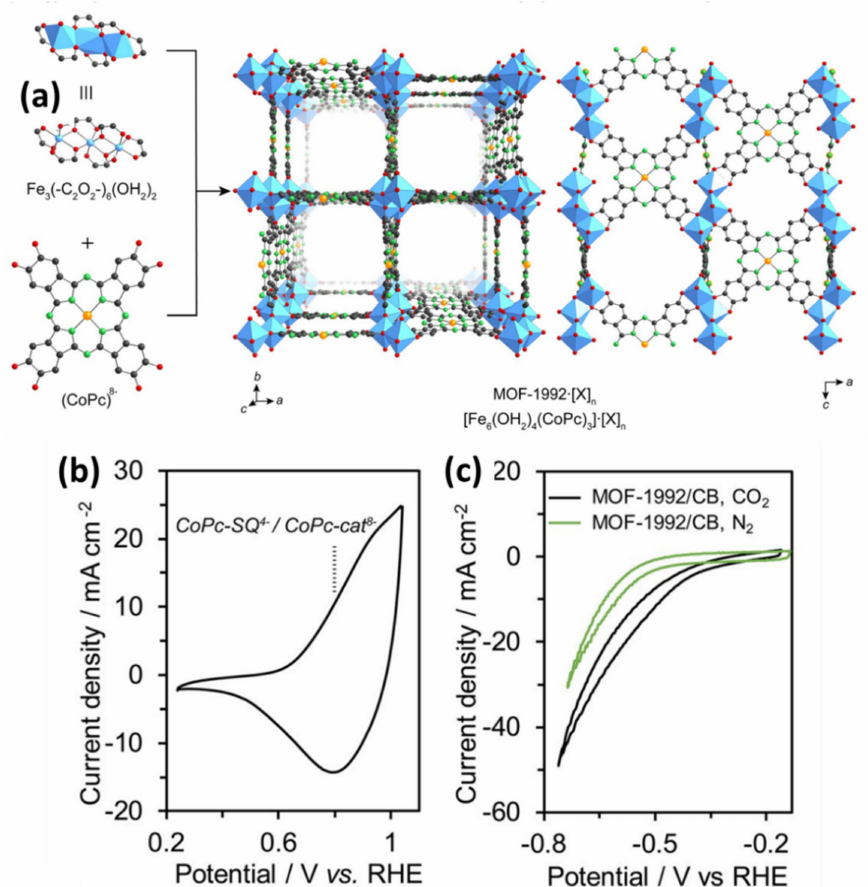
Figure 10. ( a ) Single-crystal X-ray structure of MOF-1992 based on the Fe-trimers and Co- phthalocyanine catechollinkers (CoPc). Atoms color: C-black; O-red; N-green; Co-orange; Fe- blue polyhedra. Hydrogen atoms and the chlorido ligands are omitted. The anionic charge of [Fe 6 (OH 2 ) 4 (CoPc) 3 ] 6 -, MOF-1992, was balanced by the presence of [X] n counterions (X represents Mg 2+ or Fe 3+ ). Electrochemical characterizations of the MOF-1992 ( b ) Cyclic voltammetry (CV) of the MOF-1992/CB (CB, carbon black). The vertical line display the potential of Co-Pc-semiquinolate (CoPc-SQ) 4-/CoPc-catecholate (CoPc-cat) 8-redox couple ( c ) CV of the MOF-1992/CB in a CO 2 - saturated (black, pH = 6.8) and N 2 -saturated (green, pH = 7.2) KHCO 3 solution. Reproduced from [165], with permission from American Chemical Society,